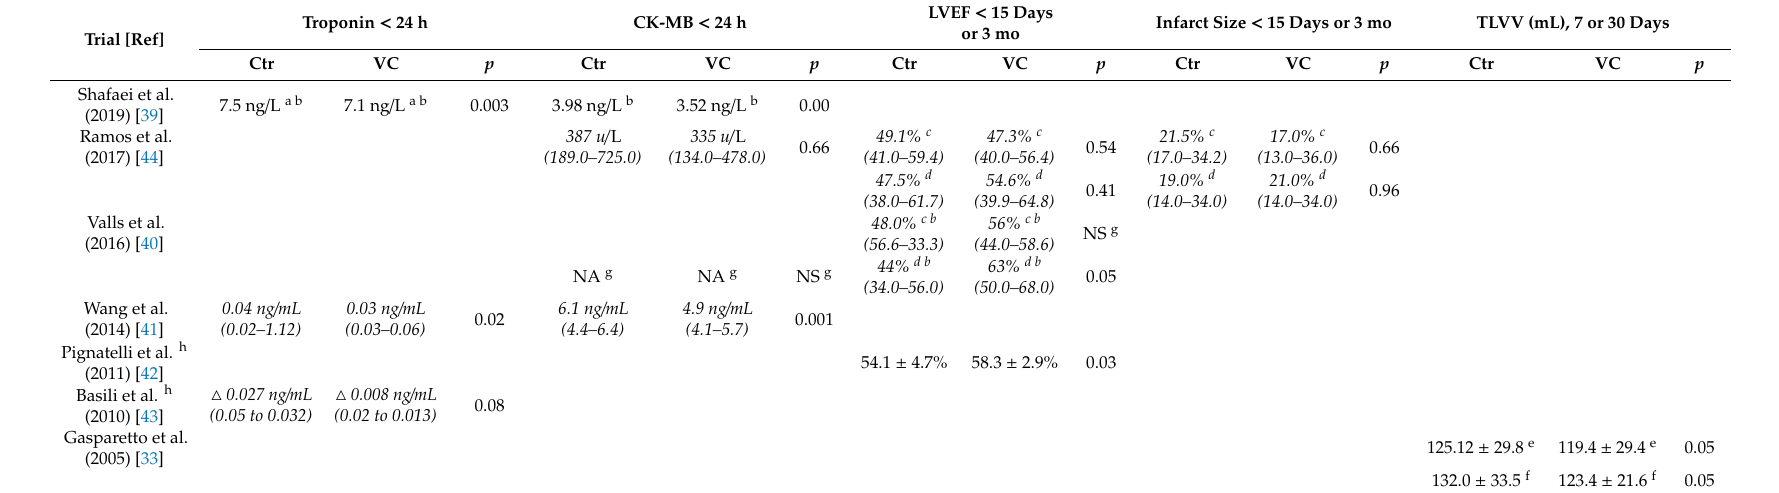
Table 2. Cardiac Injury and Functional Outcomes of Vitamin C